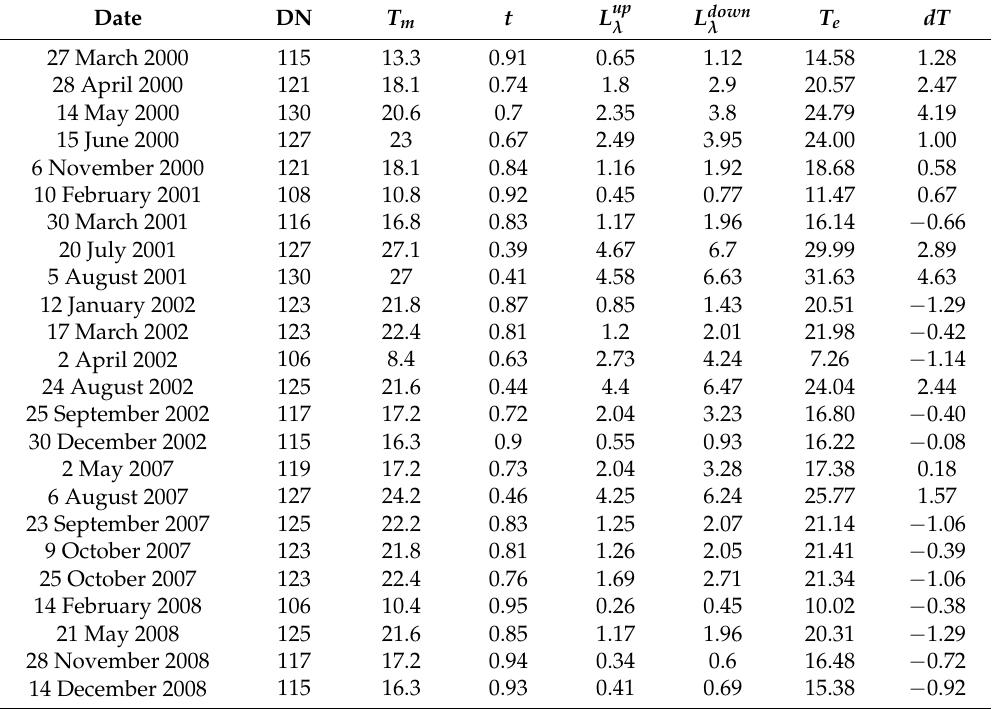
Table 1. Comparison between measured water surface temperatures ( T m ) and estimated water surface temperatures ( T e ). dT is the temperature difference between the measured and estimated water surface